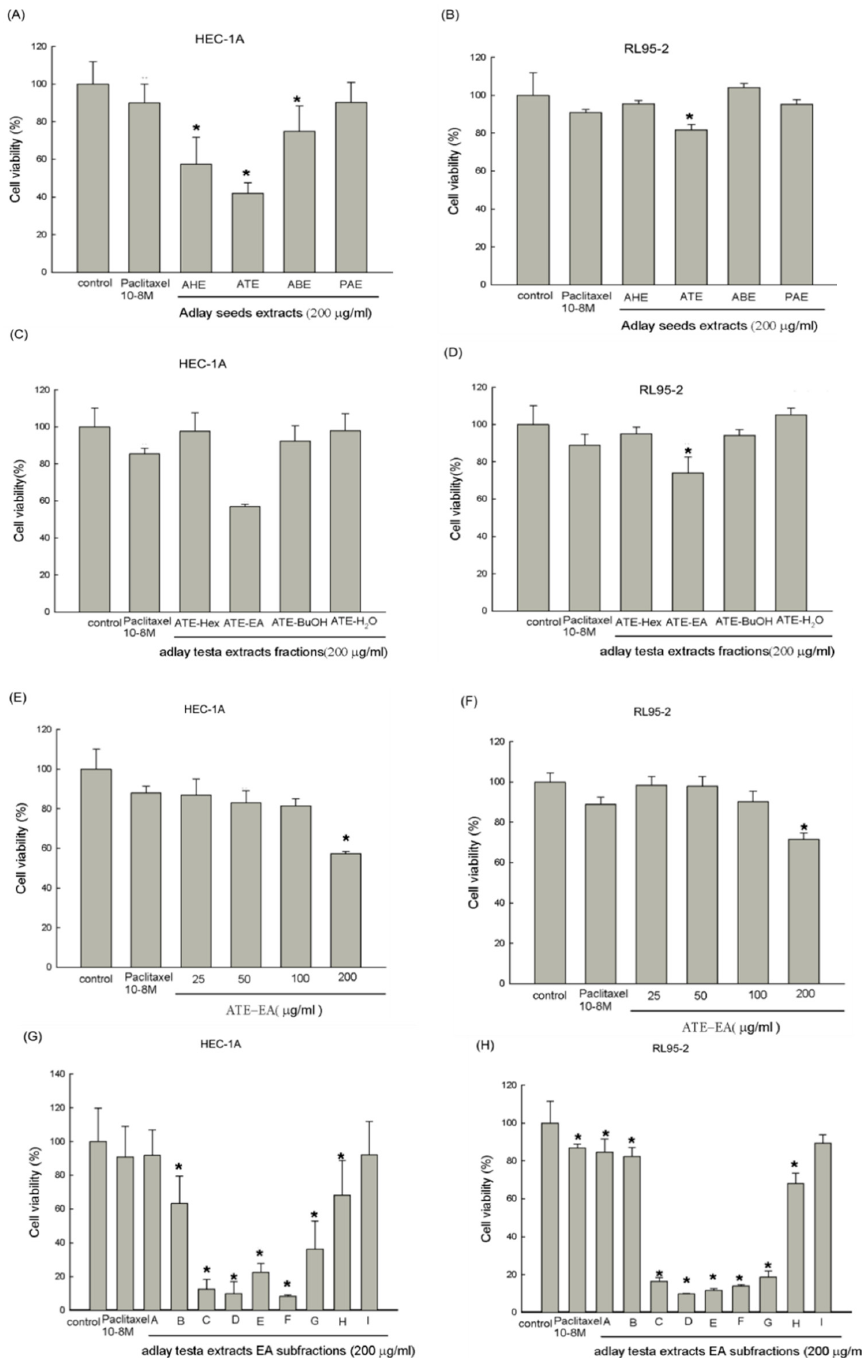
Figure 1. Effects of adlay seed ethanolic extracts on the viability of HEC-1 and RL95-2 cells. The effect of ethanolic extracts from different parts of the adlay seed on the viability of HEC-1 ( A ) and RL95-2 ( B ) cells. The effect of different fractions of adlay testa ethanolic extract (ATE) on the growth of HEC-1A ( C ) and RL95-2 ( D ) cells. HEC-1A cells and RL95-2 cellswere treated with different concentrations ( E, F ) and subfractions ( G, H ) of the ethyl acetate fraction of the adlay testa ethanolic extract (ATE-EA) for 48 h, respectively. Data are expressed as means ± SD ( n = 3). * p < 0.05, compared with the control group at the basal level. AHE, ethanolic extracts of adlay hull; ATE, ethanolic extracts of adlay testa; ABE, ethanolic extracts of adlay bran; PAE, ethanolic extracts of polished adlay; ATE-Hex, n-hexane fraction of adlay testa ethanolic extract; ATE-BuOH, 1-butanol fraction of adlay testa ethanolic extract; ATE-H 2 O, H 2 O fraction of adlay testa ethanolic